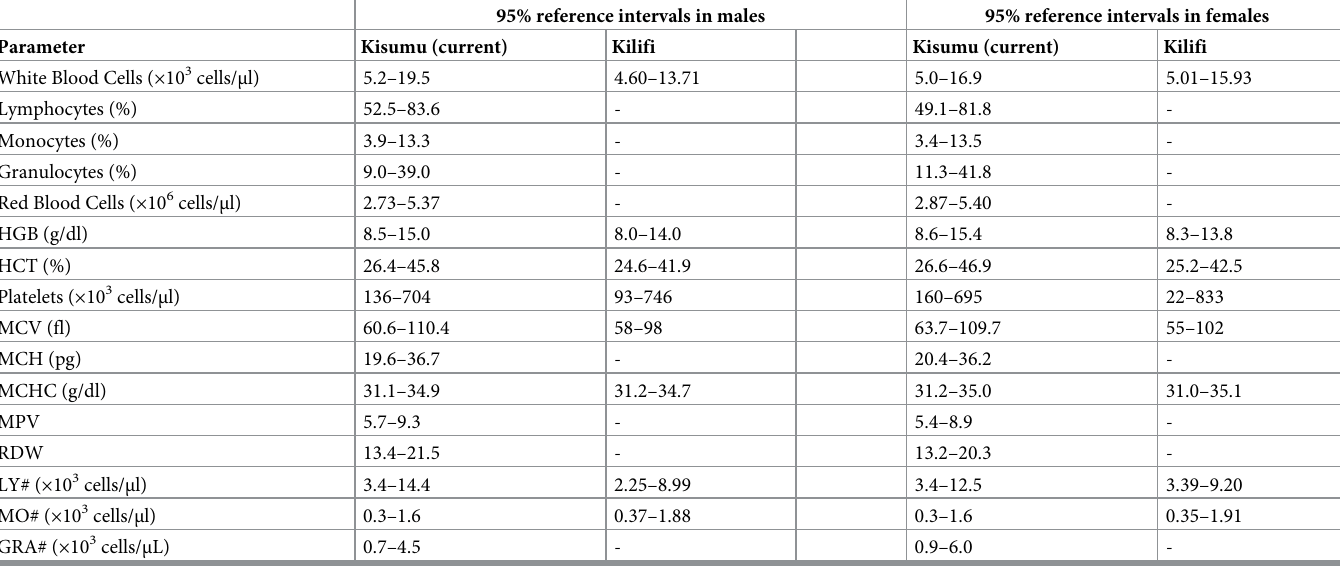
Table 5. Comparison of 95% hematological reference intervals for infants aged 1m to 6months between Kisumu and Kilifi.